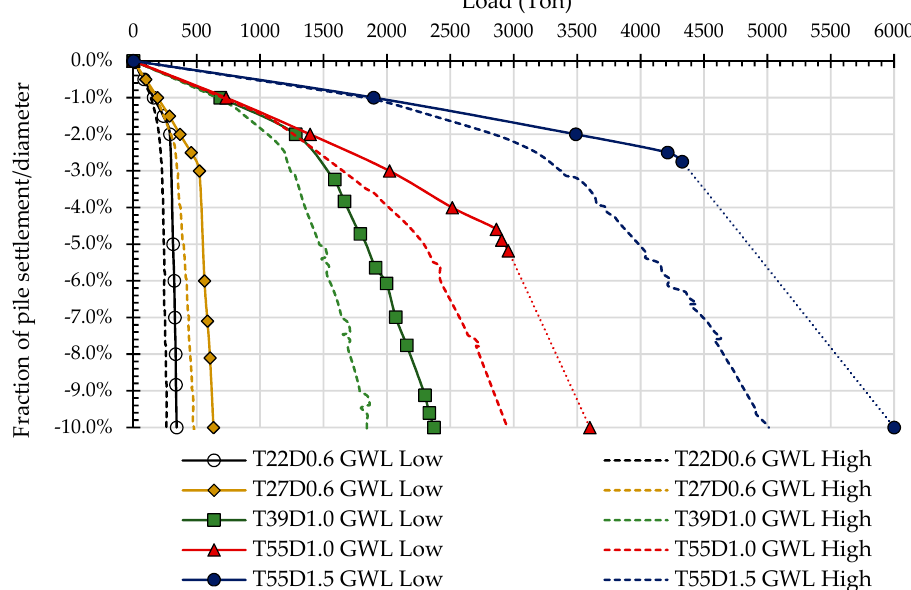
Figure 13. Reduction of pile capacity with rising groundwater level.